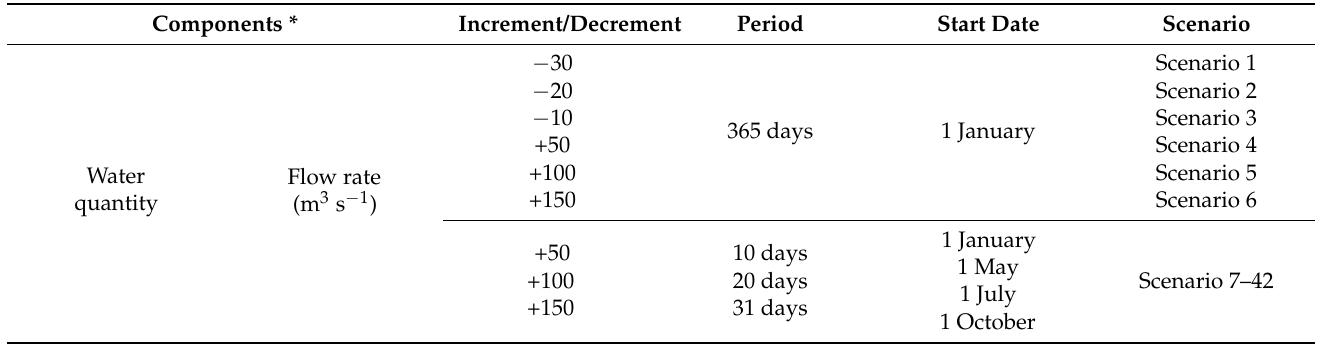
Table 5. Scenarios constructed for an understanding of NO 3 -N dynamics